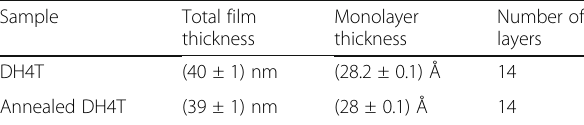
Table 2 Structural parameters extracted from the XRR fits for the film before and after thermal annealing Sample